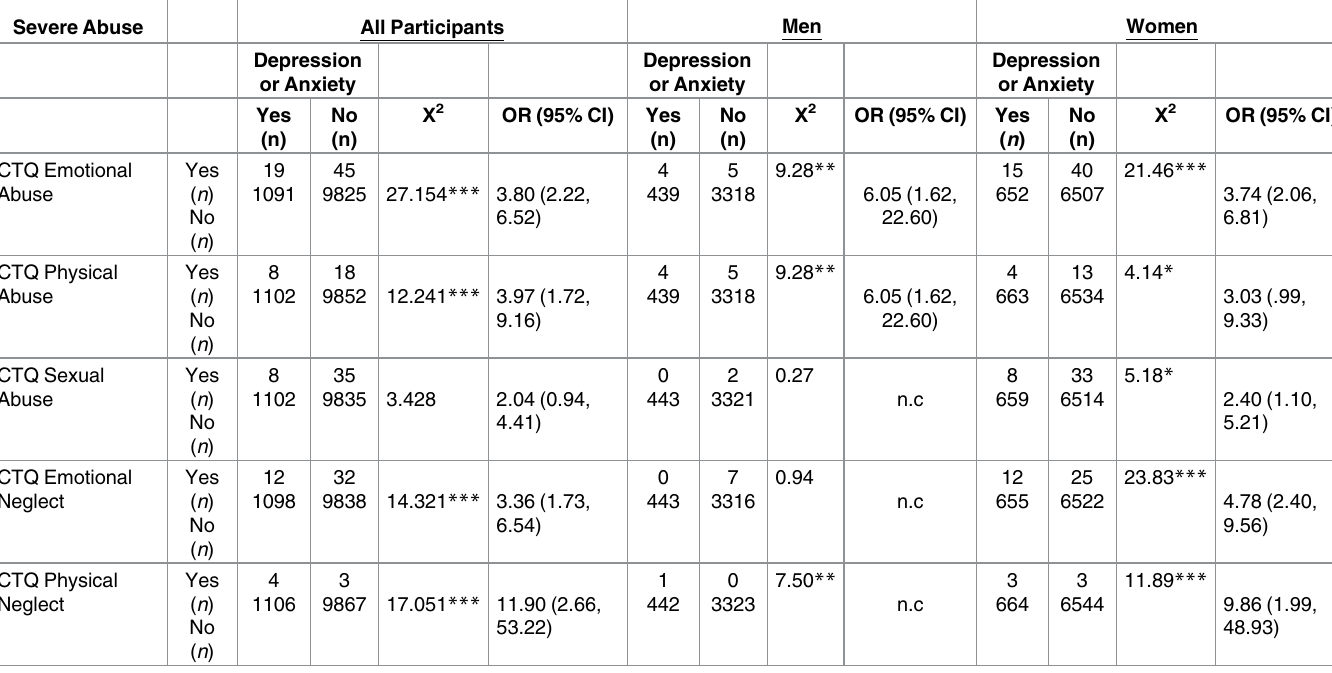
Table 3. Differencesbetween men and women in severeexperiencesof different types of maltreatment on clinical cases of depression and anxiety. Severe Abuse All Participants Men Women Depression or Anxiety